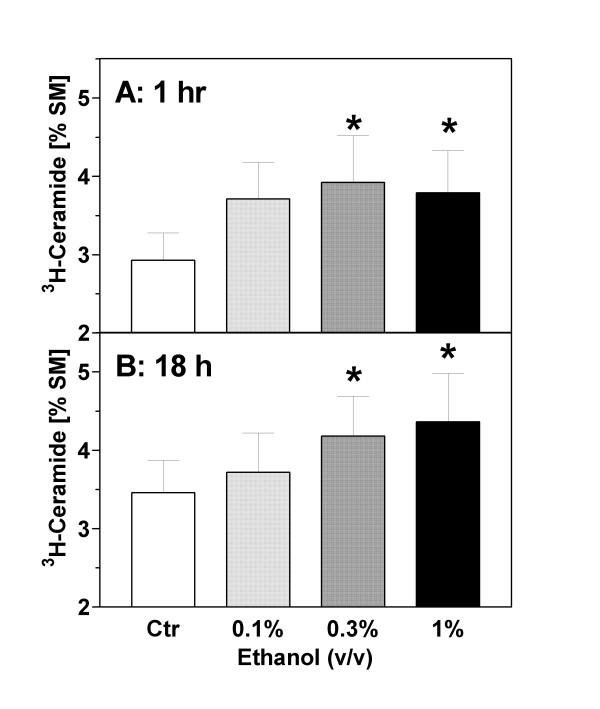
Formation of ceramide in ethanol-treated astrocytes: concentration dependence. Astrocytes were labeled with 3H-serine for 72 hours, washed and treated with ethanol (0.1–1 %, v/v). After (A) 1 hour and (B) 18 hours, the cells were extracted with methanol/chloroform (2:1), phospholipids were separated by TLC, and the radioactivity associated with ceramide and sphingomyelin was determined by liquid scintillation counting. Data (N = 5–6) are means ± S.E.M. and are expressed as [%] ceramide/sphingomyelin. Statistics: one-way ANOVA for repeated measurements, (A) F3,19 = 3.98, p = 0.03; (B) F3,23 = 4.88, p = 0.02. *, p < 0.05 vs. controls (Dunnett's post test).